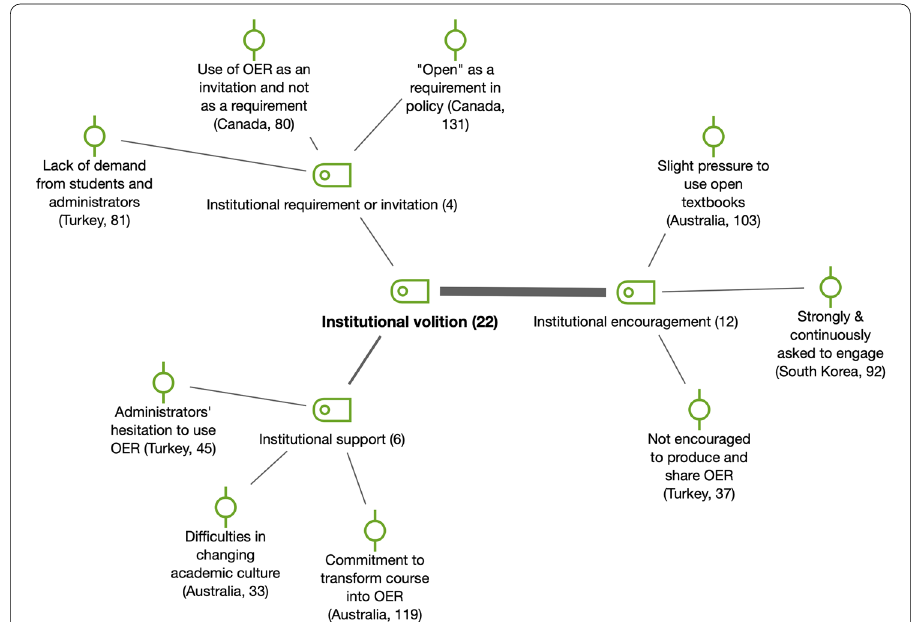
Fig. 9 Subcodes and examples for institutional volition